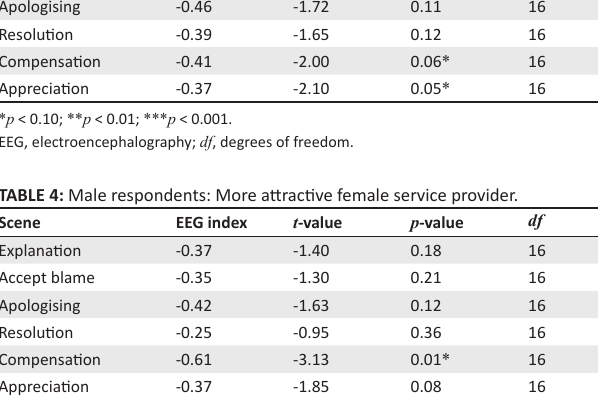
Table 5 explores female respondents’ responses to individual